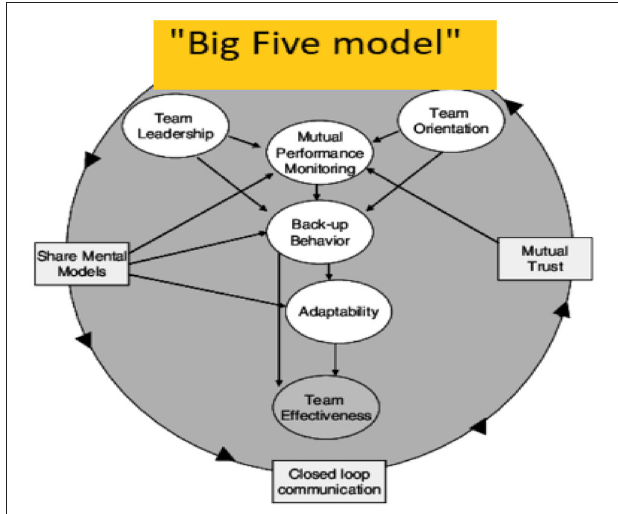
FIGURE 1 | Graphical representation of high-level relationships between the big five and the coordinating mechanisms (Salas et al.,